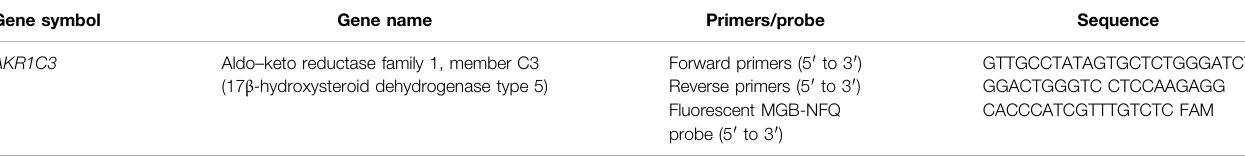
TABLE 2 | Sequences of the primers and probe for speci fi c ampli fi cation of AKR1C3 .